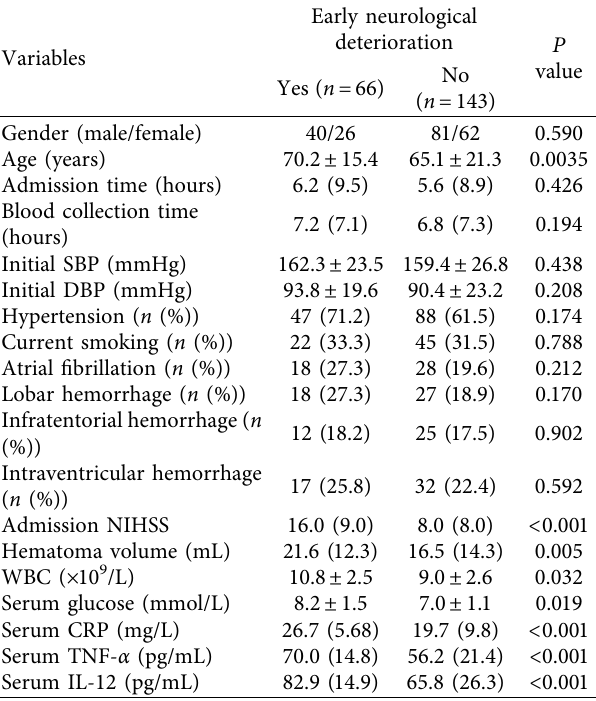
Table 3: Factors associated with early neurological deterioration in patients with